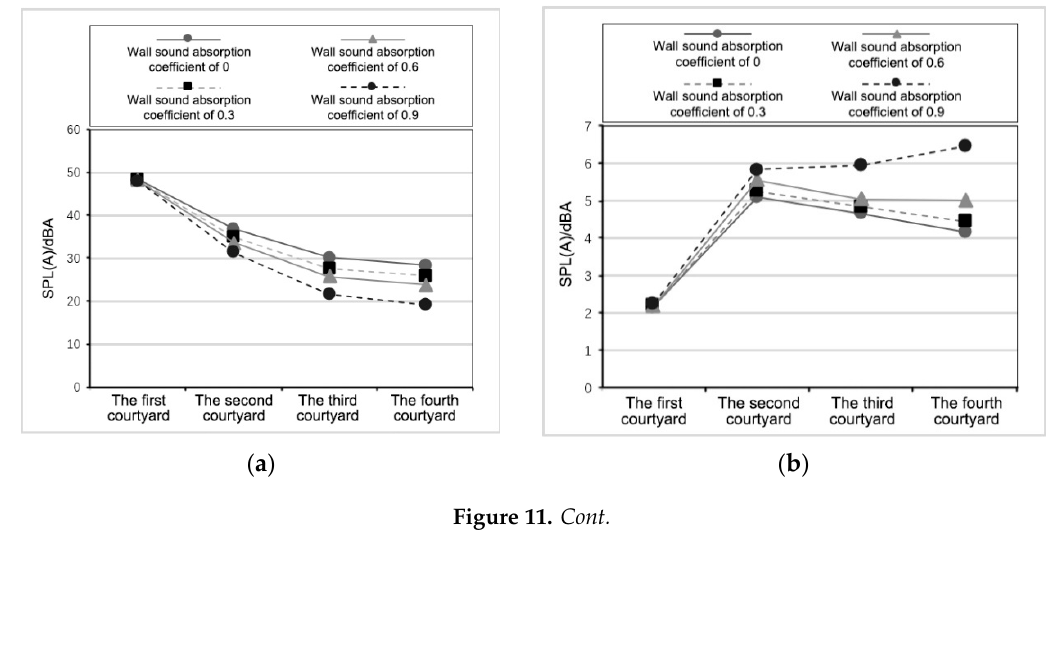
Figure 10. Diagrams of the effects of bell tower height on courtyard sound fields. ( a ) Variation in RT. ( b ) Variation in C 80